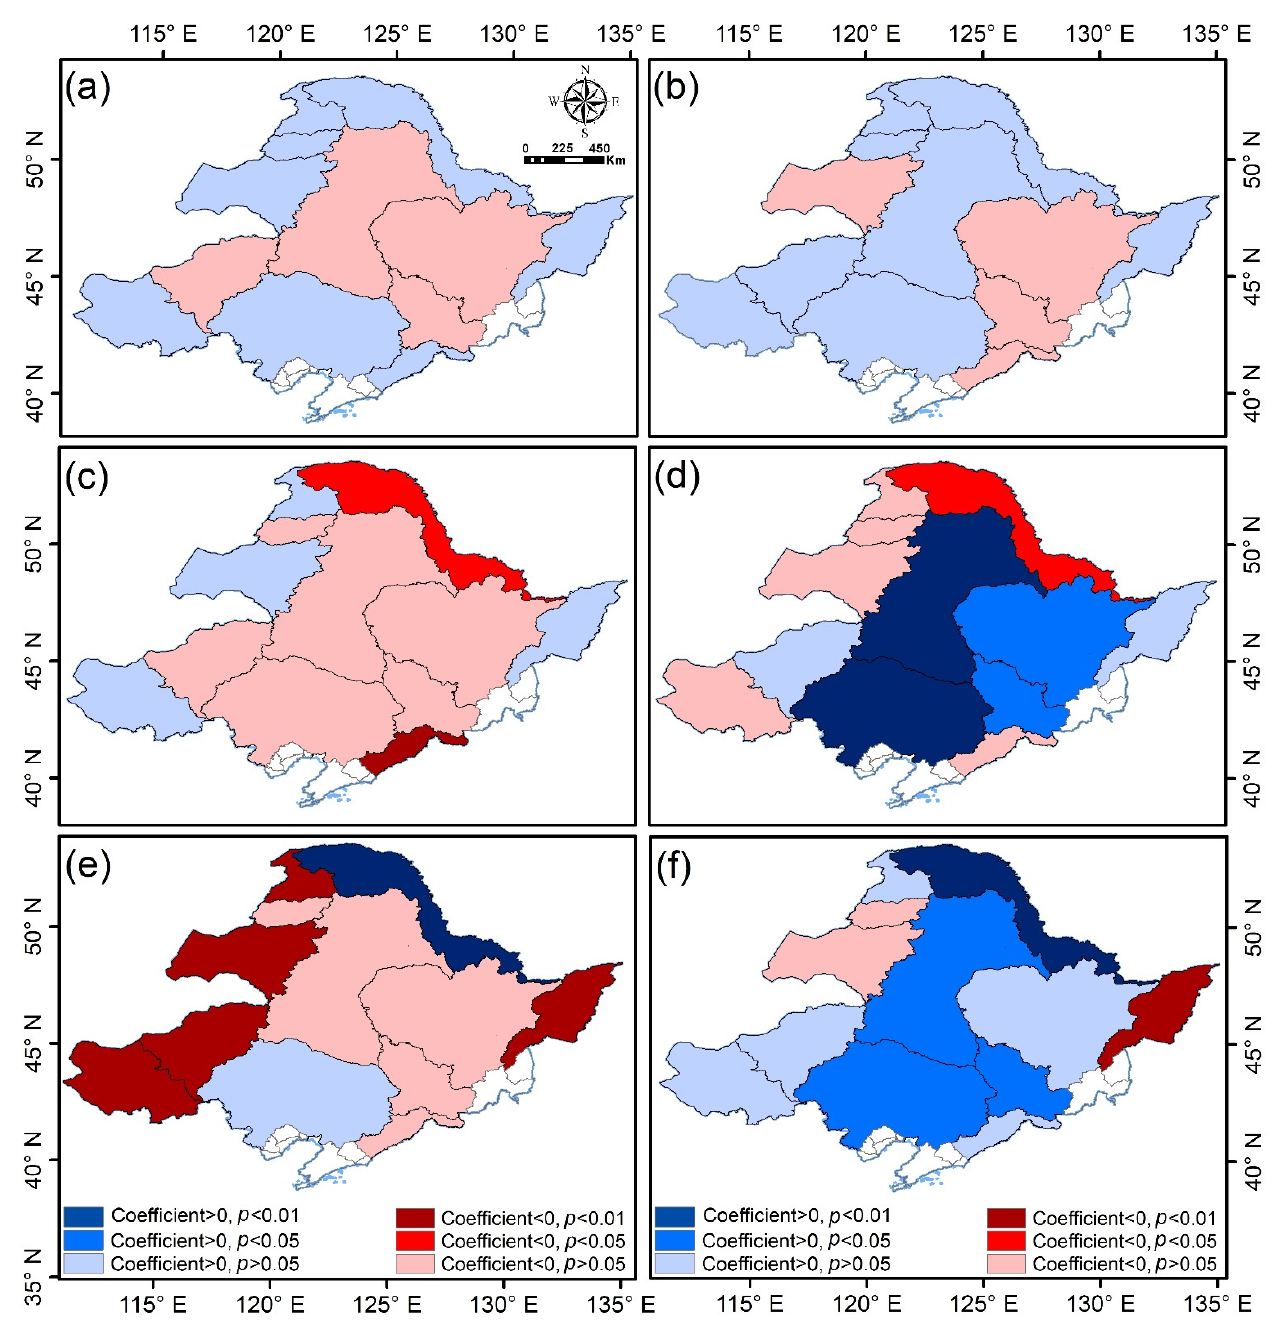
Figure 8. Spatial distribution of correlations of SSWA, PSWA, and NDVI in the watershed: ( a , b ) are